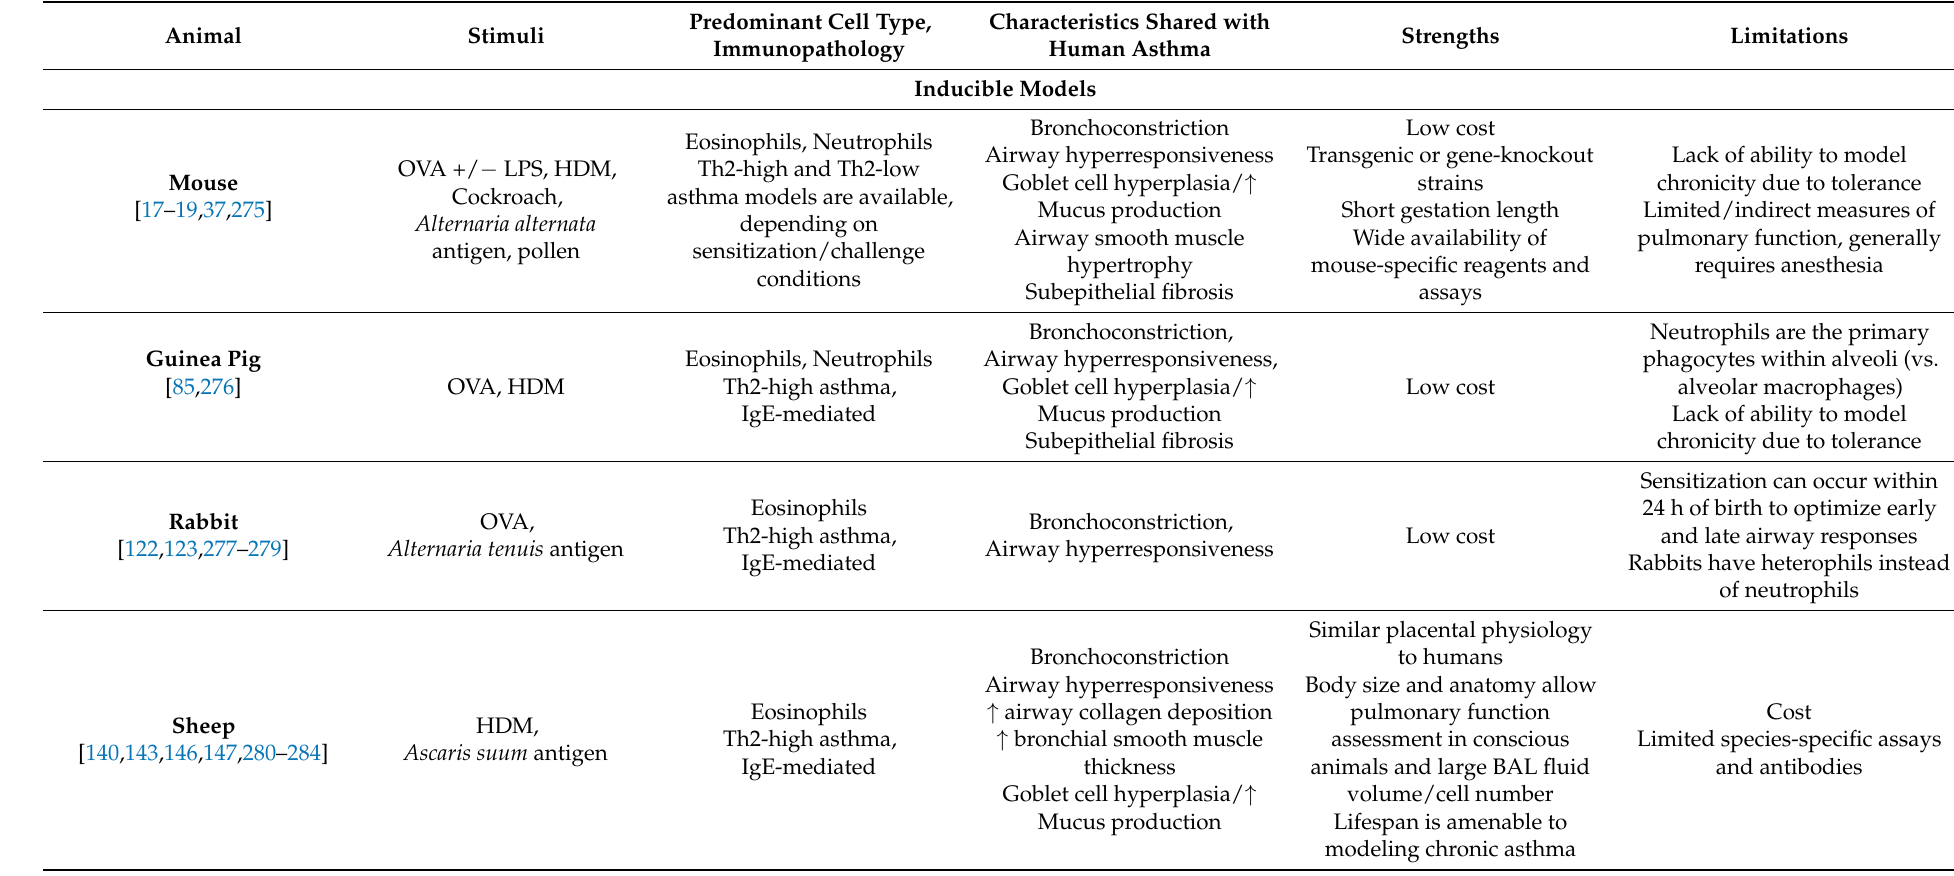
Table 2. Animal Models of